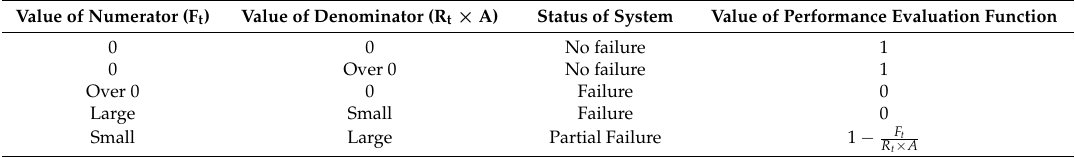
Table 2. The value of the performance evaluation according to the numerator and